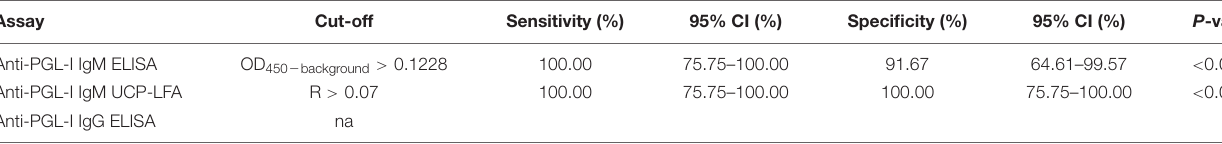
TABLE 1B | Assay performance to discriminate (highly) susceptible and resistant armadillos ( n = 17)*.